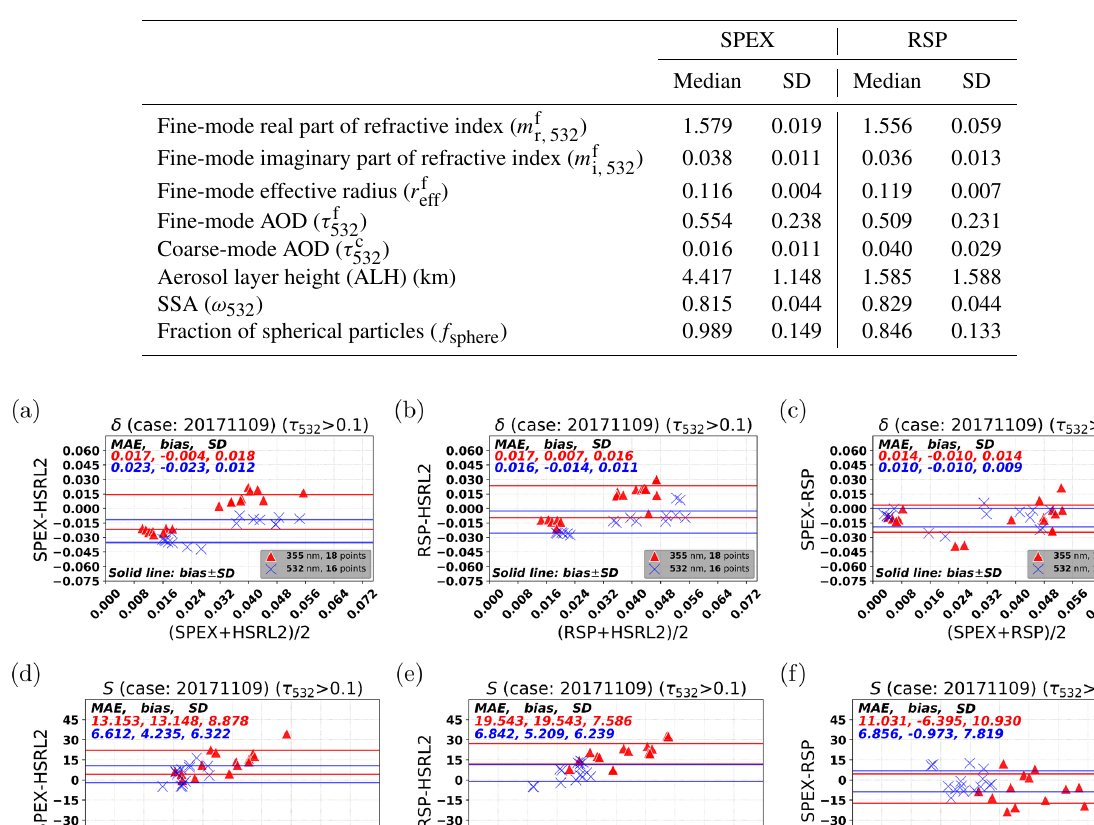
Table 3. Median and standard deviation (SD) properties of the smoke plume from SPEX and RSP when AOD > 0 . 2 at 532nm.